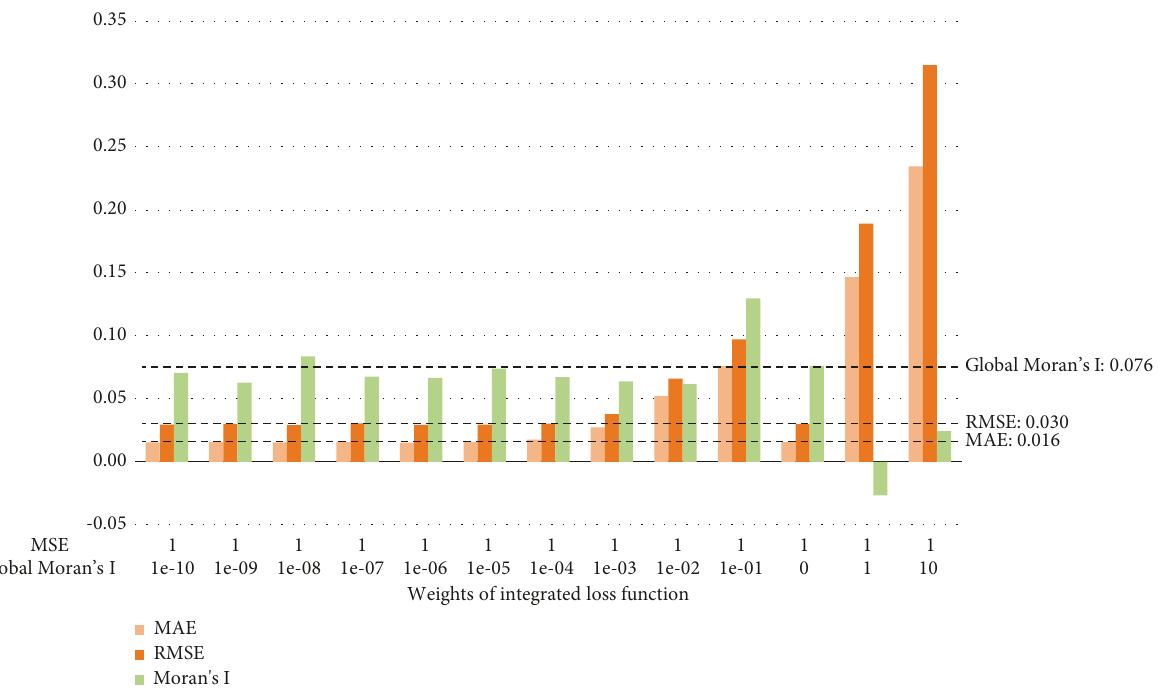
Figure 7: Performance metrics and global Moran’s I of the Conv-LSTM model varying over-weighted